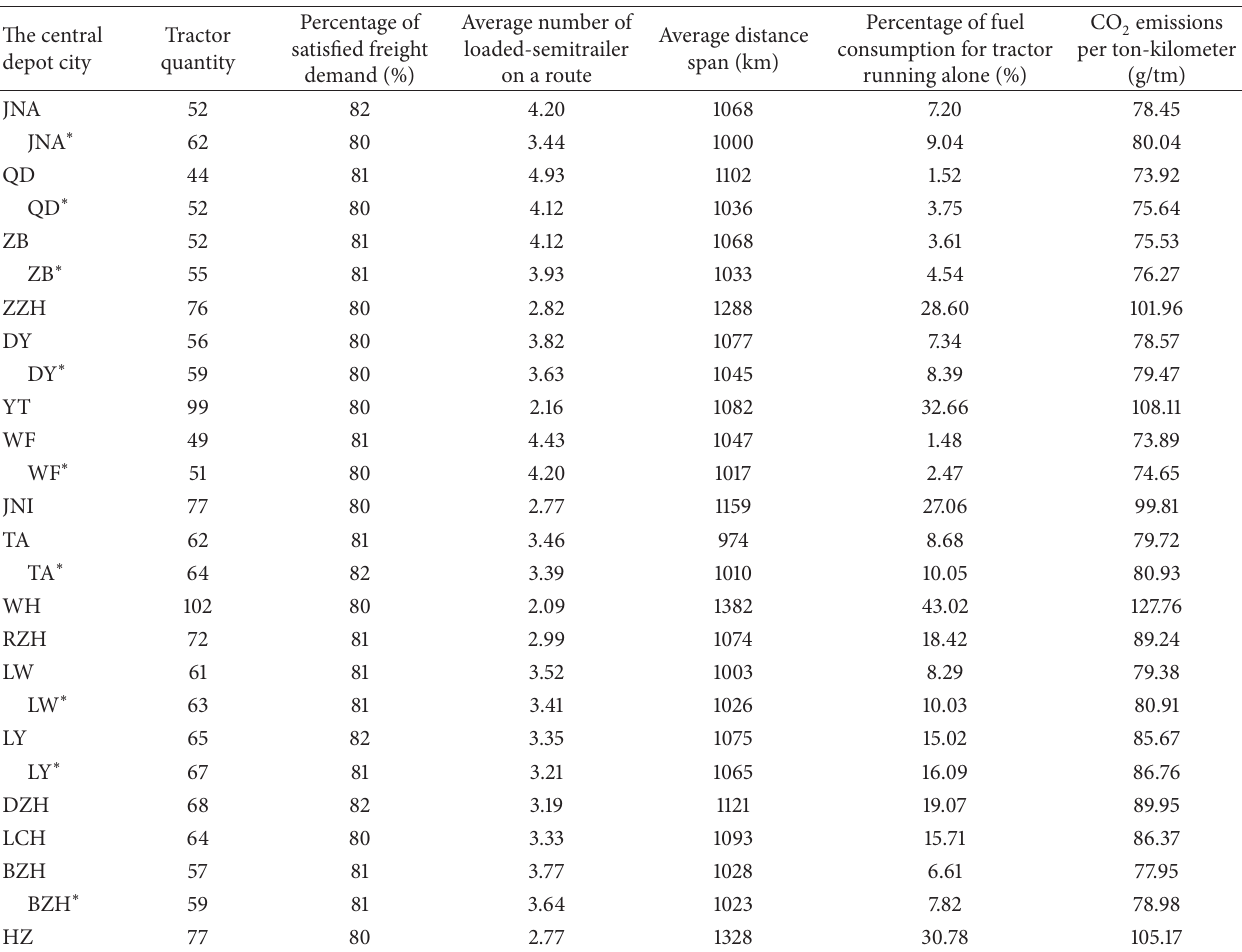
∗ The results without clone